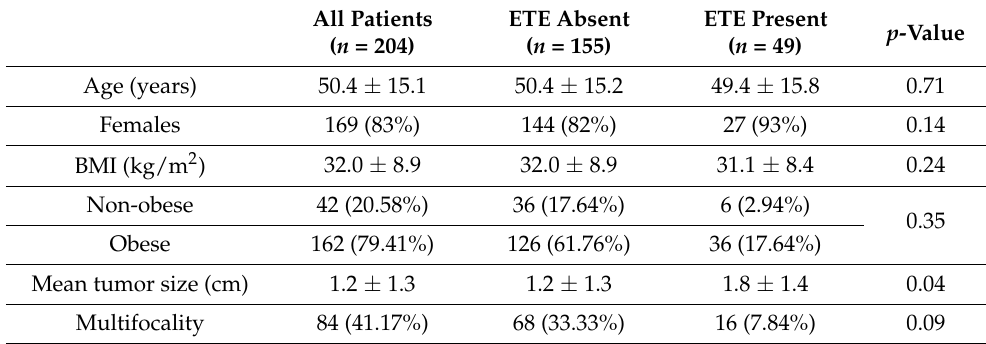
Table 1. Characteristics of study population. Data is presented as mean ± standard deviation and frequency with its corresponding percentage (%). All Patients ETE Absent ( n = 204) ( n =